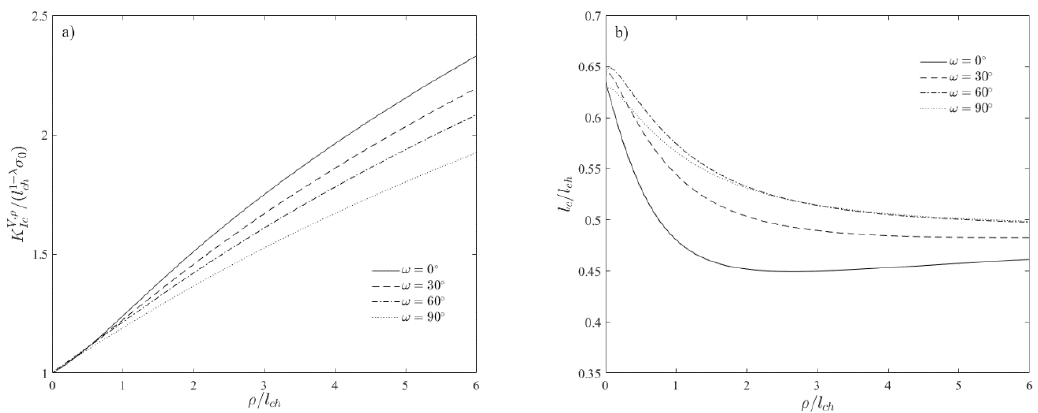
Figure 7. Average FFM: Dimensionless apparent generalized fracture toughness ( a ) and dimensionless critical crack extension ( b ) compared to dimensionless notch root radius.